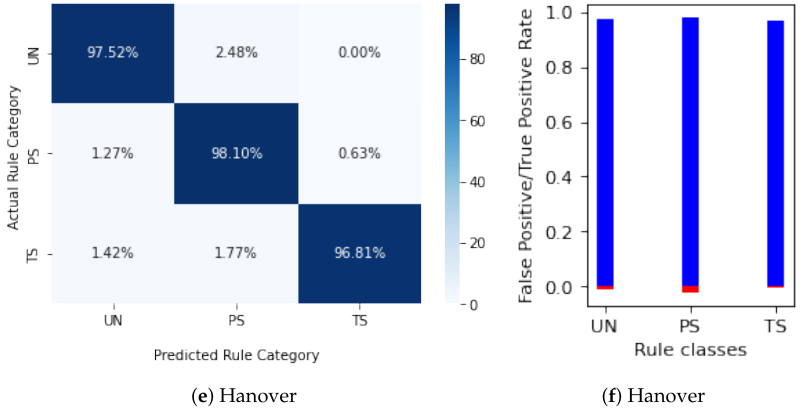
Figure 14. Confusion matrices and false/true positive rates for the three datasets after applying consistency check using domain knowledge